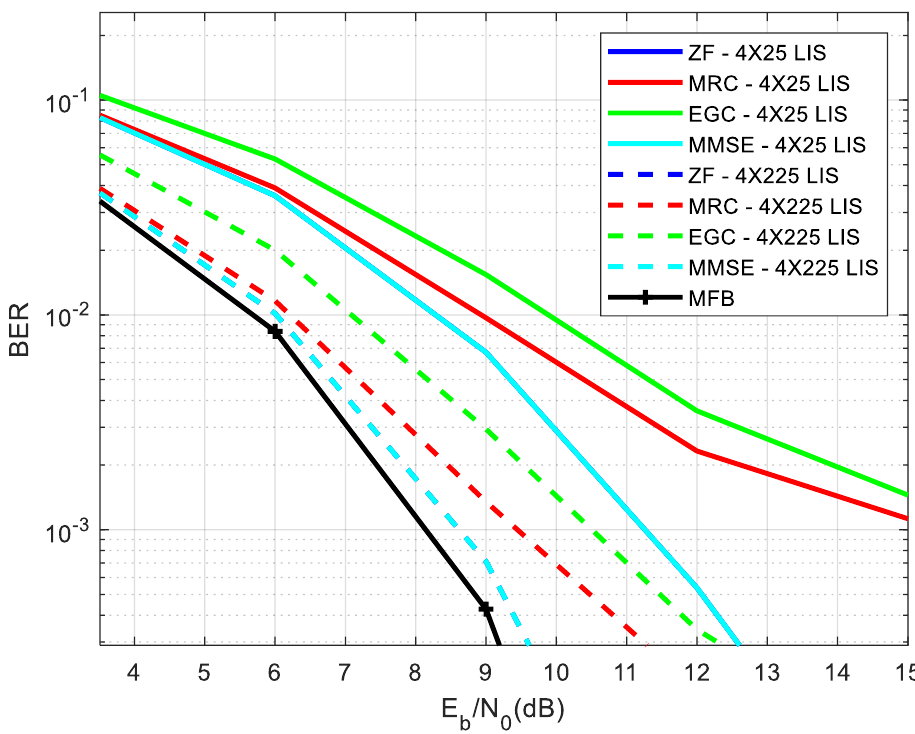
Figure 6. Results for 4X25 versus 4X225 LIS System, with 2 users, without LDPC codes.